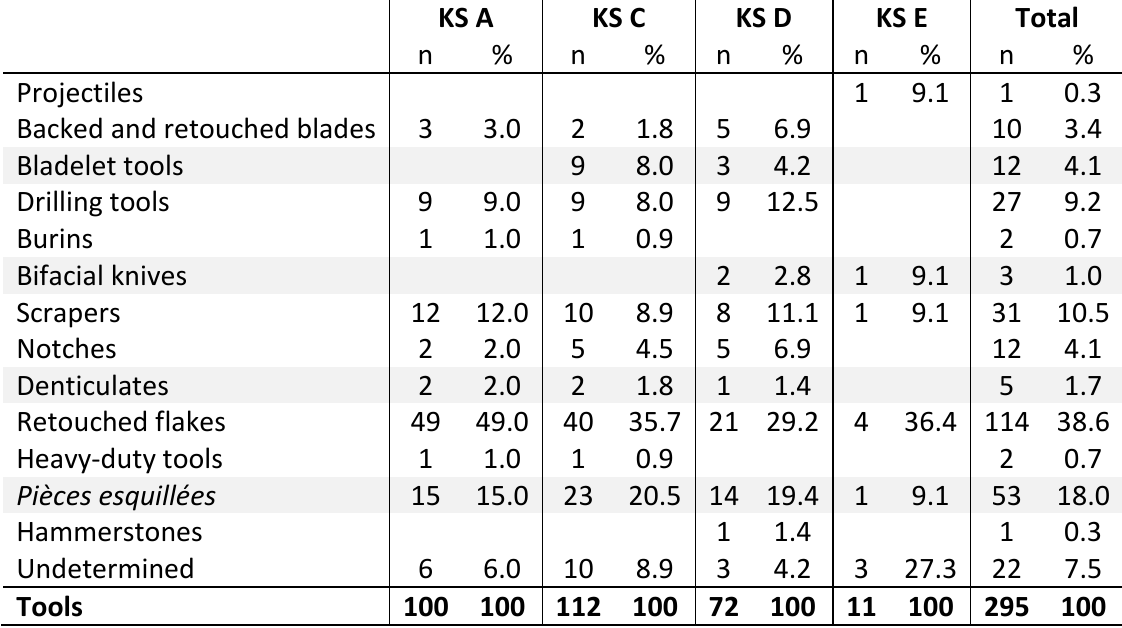
Table 7. Breakdown of tools at Karmir